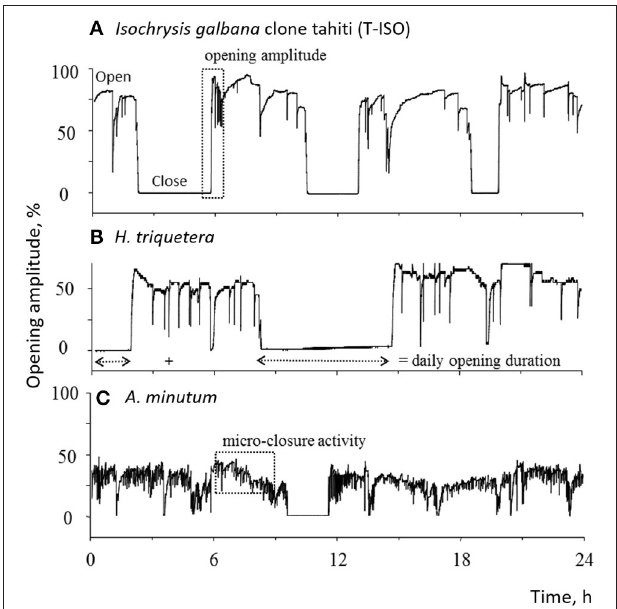
FIGURE 3 | Typical records of valve activity behavior of Crassostrea gigas during a 1-day period feed with the non-toxic algae (A) Isochrysis galbana clone tahiti (T-ISO), (B) Heterocapsa triquetra and the toxic dinoflagellate (C) Alexandrium minutum . Three parameters were used to characterize the behavior: daily valve-opening duration; daily valve micro-closure; valve-opening amplitude. Behavior comparisons are drawn under simplified but well controlled laboratory conditions to study the effects of environmental (e.g., temperature) and anthropogenic (e.g., toxic algae exposure) stressors upon bivalves. Reprinted from Aquaculture 298 (2010) 338–315 with permission. Minor text modifications performed on the original figure text.